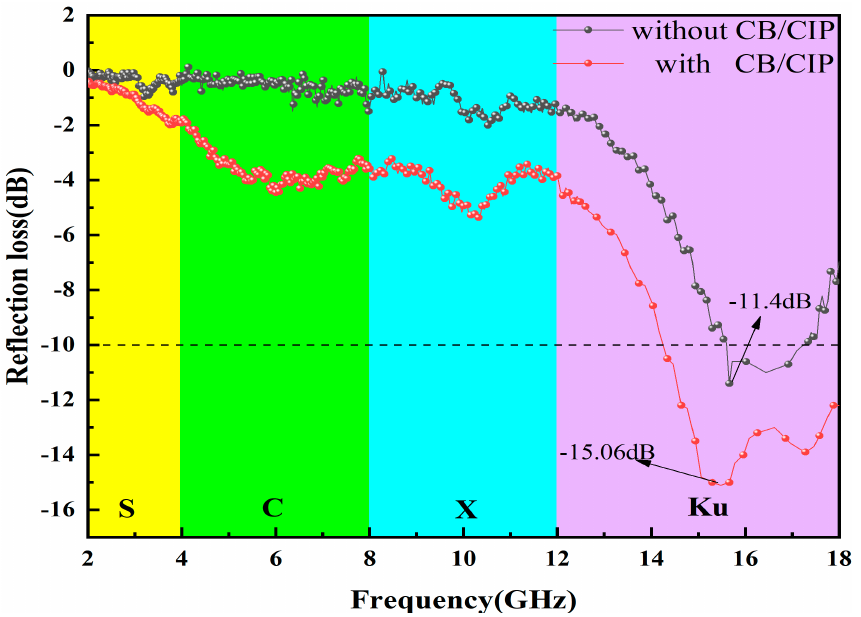
Figure 7. EM wave absorption performance of S0 and S1.